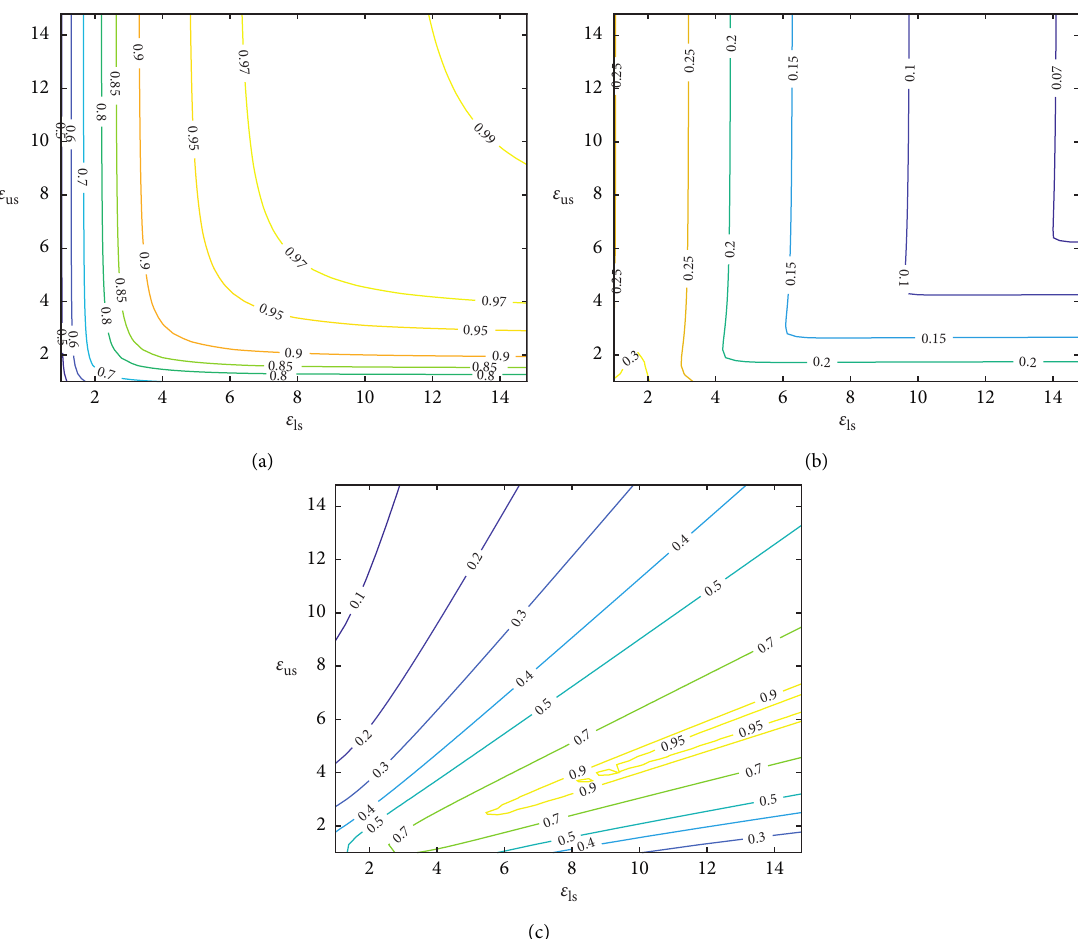
Figure 2: Mode frequency ratios with various ε